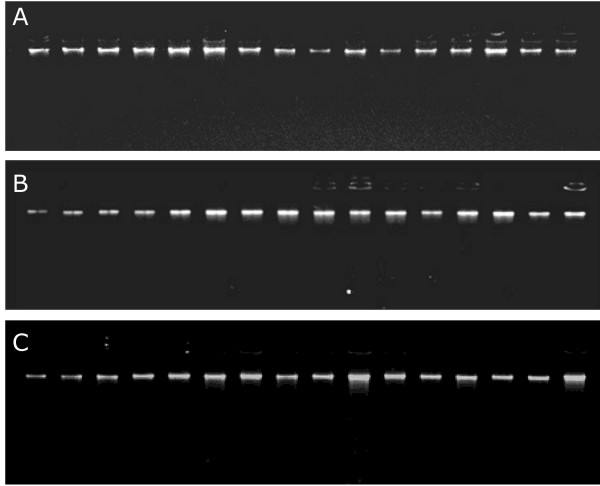
Reproducibility of enzymatical isolation of DNA. (A) From leaf disks of 16 individuals of Aster amellus (one tenth of the isolated DNA was loaded), (B) From 16 leaf disks of Ilex aquifolium (one fifth of the isolated DNA was loaded) and (C) From 16 seeds of Allium porum (one fifth of the isolated DNA was loaded) using Wizard® Magnetic 96 Plant System magnetic beads.